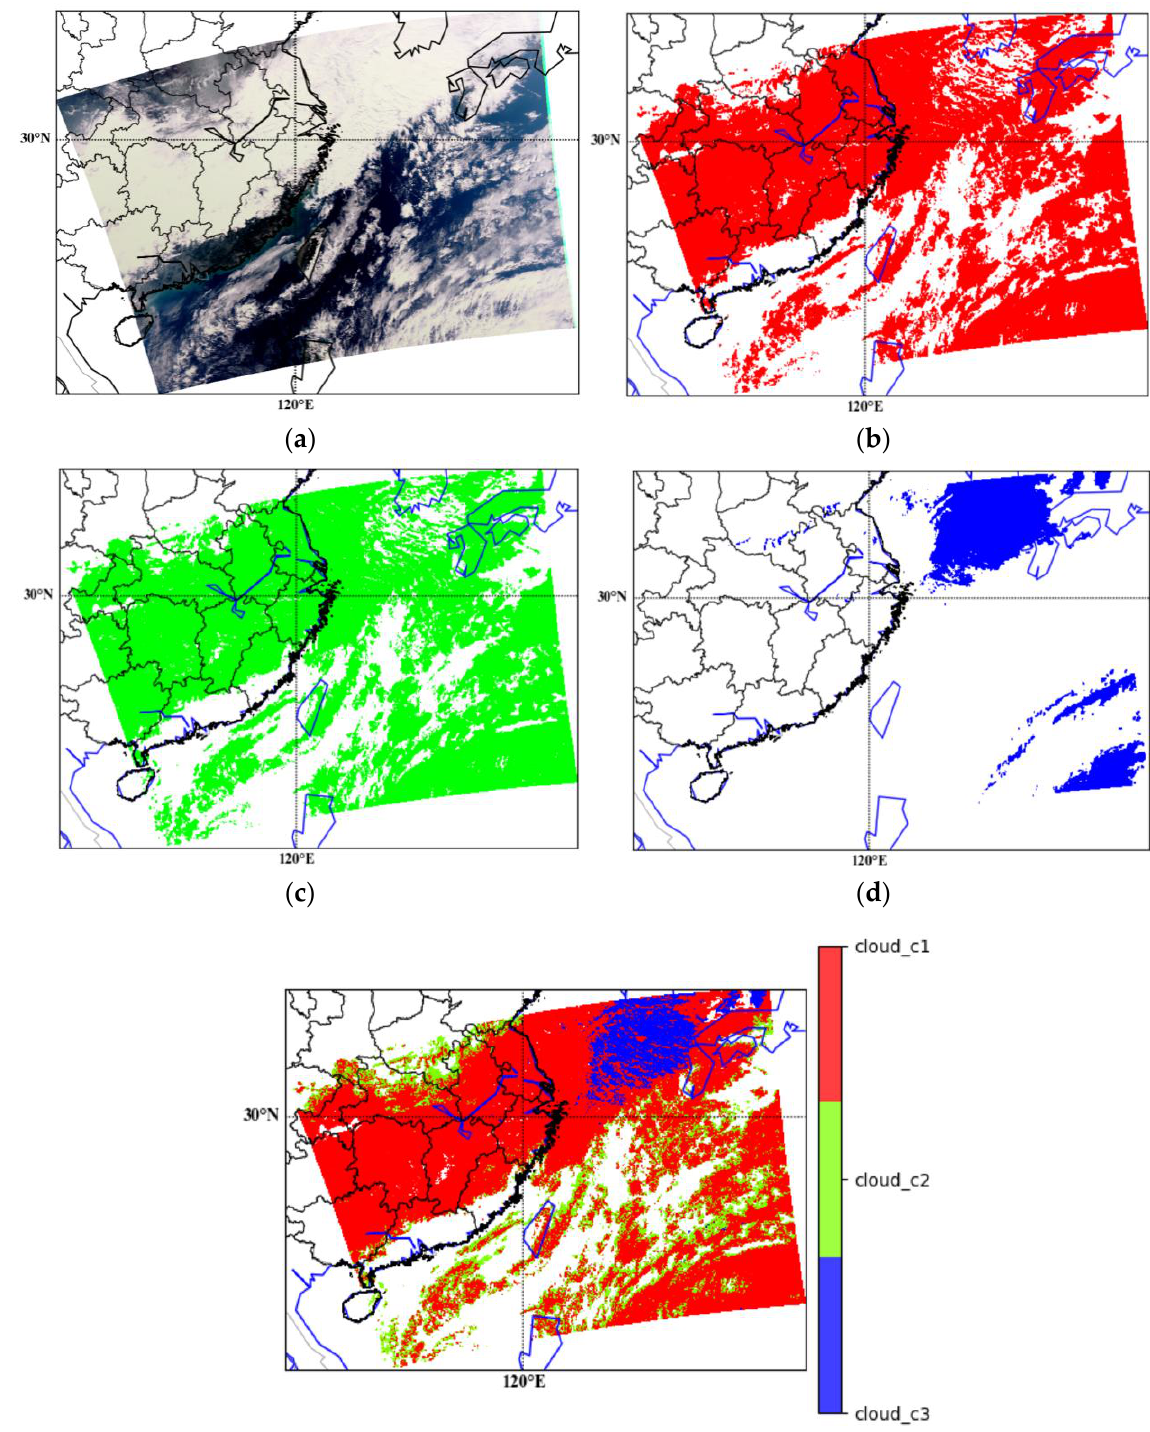
Figure 6. Test of cloud detection conditions at UTC0500 on 1 December 2019. ( a ) A true color map. ( b ) The cloudy region was detected by cloud condition 1, ( c ) the cloudy region was detected by cloud condition 2, ( d ) the cloudy region was detected by cloud condition 3 ( e ) and the final cloudy regions were detected by three conditions.